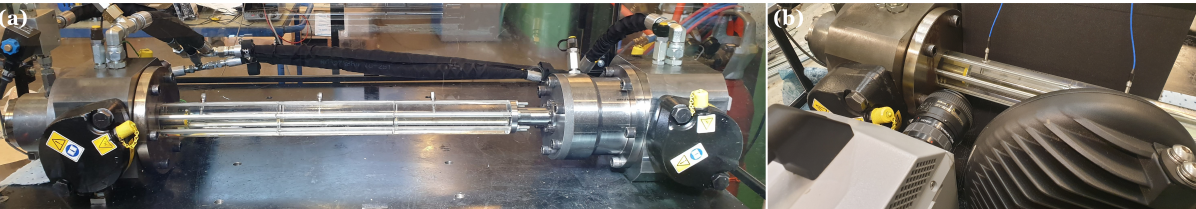
Figure 1. Test setup. ( a ) Overview of the test equipment with acrylic glass observation section. Liquid flows through the pipe from left to right and the plunger is located 80 mm from the upstream end of the pipe. ( b ) Camera setup with a 105 mm lens. One light source was placed close to the observation section while the second light source was further in the background. Table 1. Estimated cavitation numbers G A describes the relation between pressure and inertial forces, here represented by the static pressure ( p ) and the fluid deceleration ( ∆ v / ∆ t ). At lower cavitation numbers ( < 1), inertial forces are dominating and column separation would be expected. Orifice